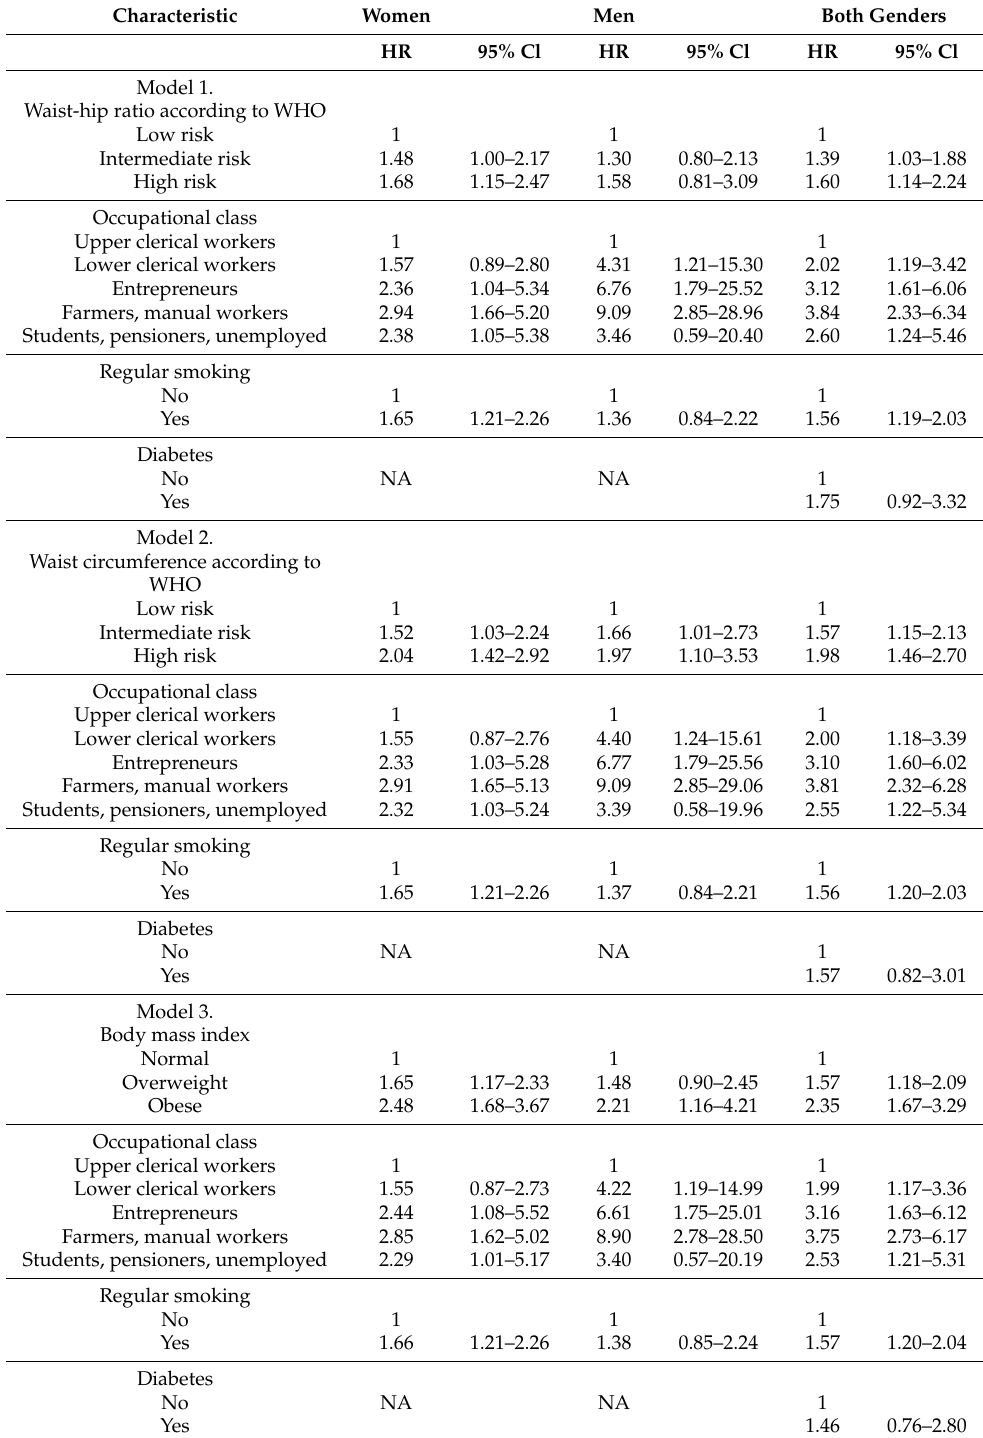
Table 2. Sex-specific and combined sexes’ full model hazard ratios (HR) with 95% confidence intervals (CI) of diagnosed carpal tunnel syndrome for body mass index (BMI), waist circumference and waist-hip ratio